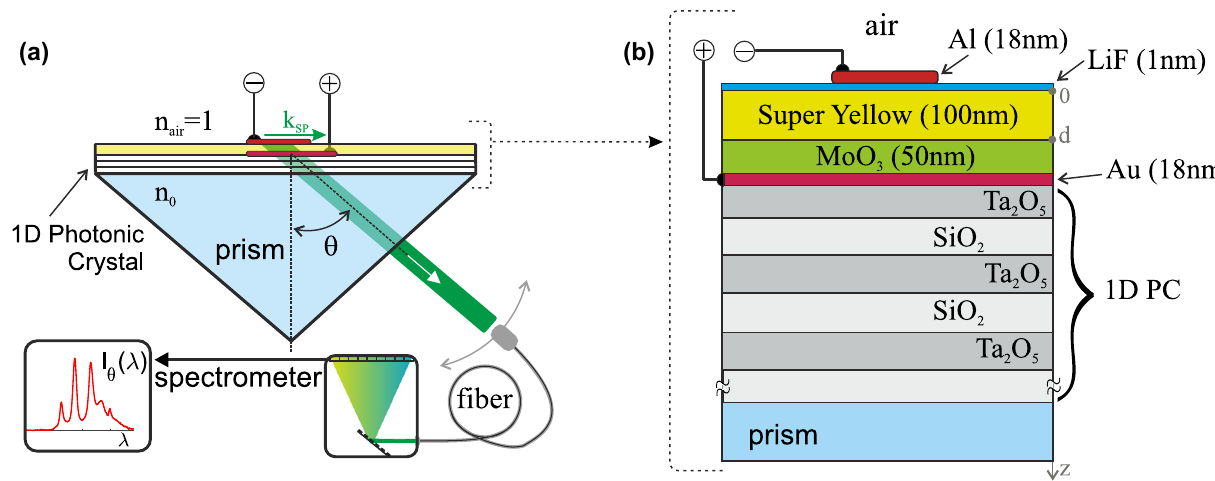
Fig. 1 a Layout of the experiment and b the PC/OLED structure with two metal